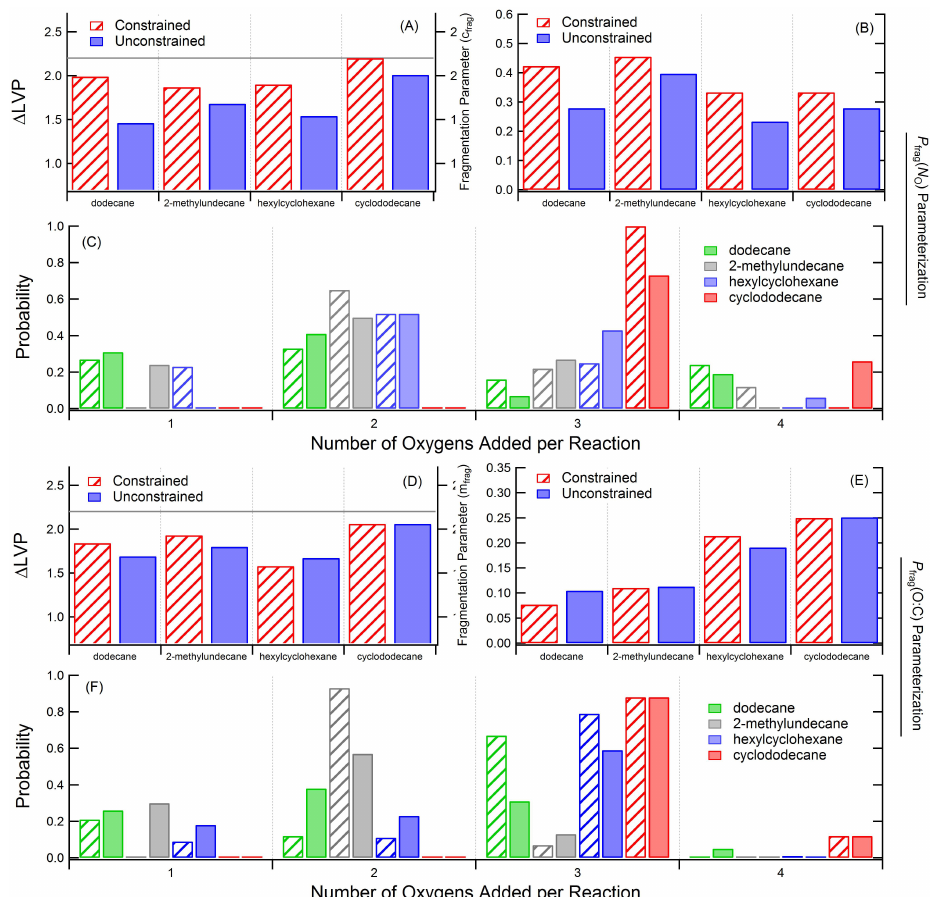
Fig. 9. Best-fit SOM parameters for dodecane, 2-methylundecane, hexylcyclohexane, and cyclodecane under high-NO x conditions for both the overall best-fit (solid bars, as in Fig. 2) and the best-fit when the c frag and m frag parameters are constrained to be equal to the low-NO x overall best-fit values (hashed bars). Results are shown for both the P frag (N O ) (A–C) and P frag (O:C) (D–F) parameterizations and include ( A and D ) 1 LVP, ( B and E ) the fragmentation parameter, and ( C and F ) the oxygen addition array. The constrained model was fit only to the observed C OA . The grey line in (A) and (D) indicates the upper-limit constraint on 1